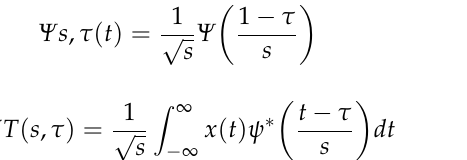
Figure 2. Location of the crack. Table 1. Defect level of the axle (crack depth).